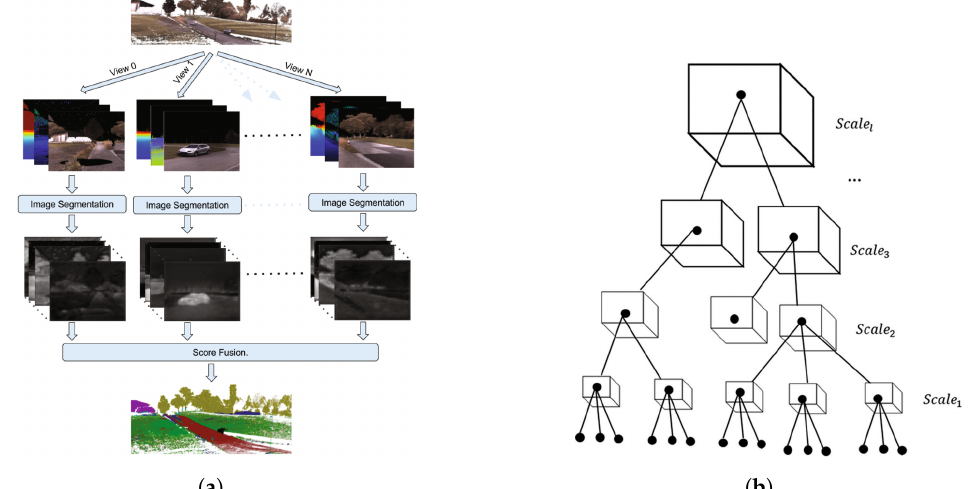
Figure 5. ( a ) Method proposed by [106] (reprinted with permission from Springer Nature: Springer, https://link.springer.com/chapter/10.1007/978-3-319-64689-3_8 Deep projective 3D semantic seg- mentation by Lawin, F.J.; Danelljan, M.; Tosteberg, P.; Bhat, G.; Khan, F.S.; Felsberg, M. COPYRIGHT (2017)). The 2D images are create by projecting the input point cloud into multiple virtual cam- era views. Semantic segmentation is conducted on for each view. The output prediction scores from all views are used to estimate a single prediction for each point. This process results in a 3D semantic segmentation of the point cloud. ( b ) The multi-scale representation of point clouds in [78] (https://www.tandfonline.com/doi/full/10.1080/13658816.2018.1552790 Using multi-scale and hierarchical deep convolutional features for 3D semantic classification of TLS point clouds. and Francis. reprinted by permission of the publisher), with the finest scale 1 at the bottom and the coarser scale l on the